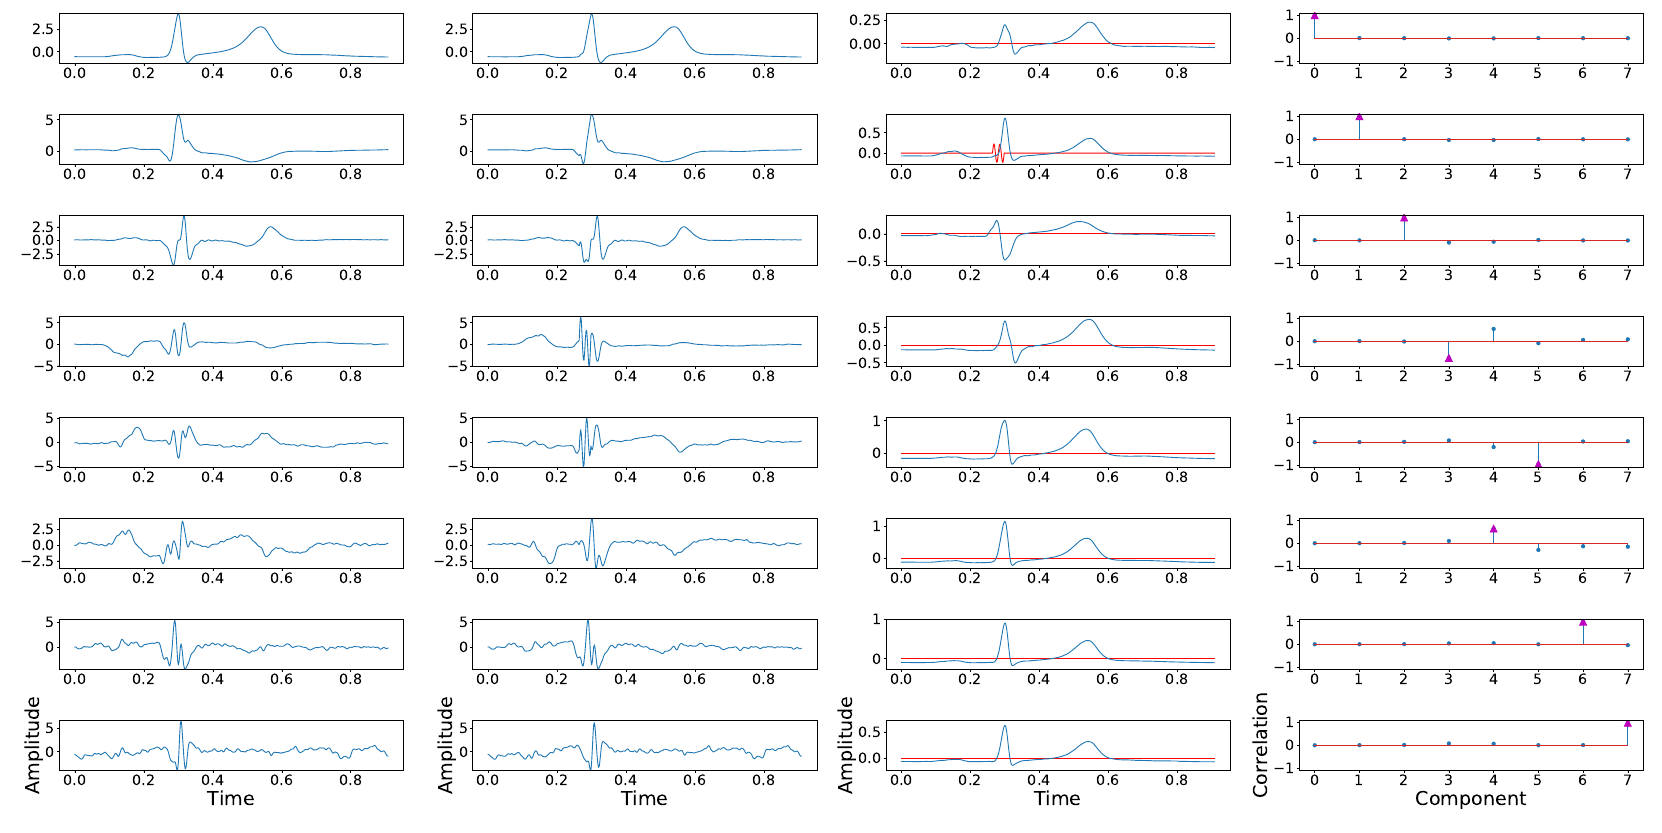
Figure 3. Example of principal component position swapping in 8 independent leads configuration. The first column shows the principal components associated with the control ECG. The second column shows the principal components derived from the synthetically fragmented replication of the control ECG. The third column shows the original signal in blue and the fragmented wave in red. The fourth column shows the PCCs between the i-th component of the control signal and